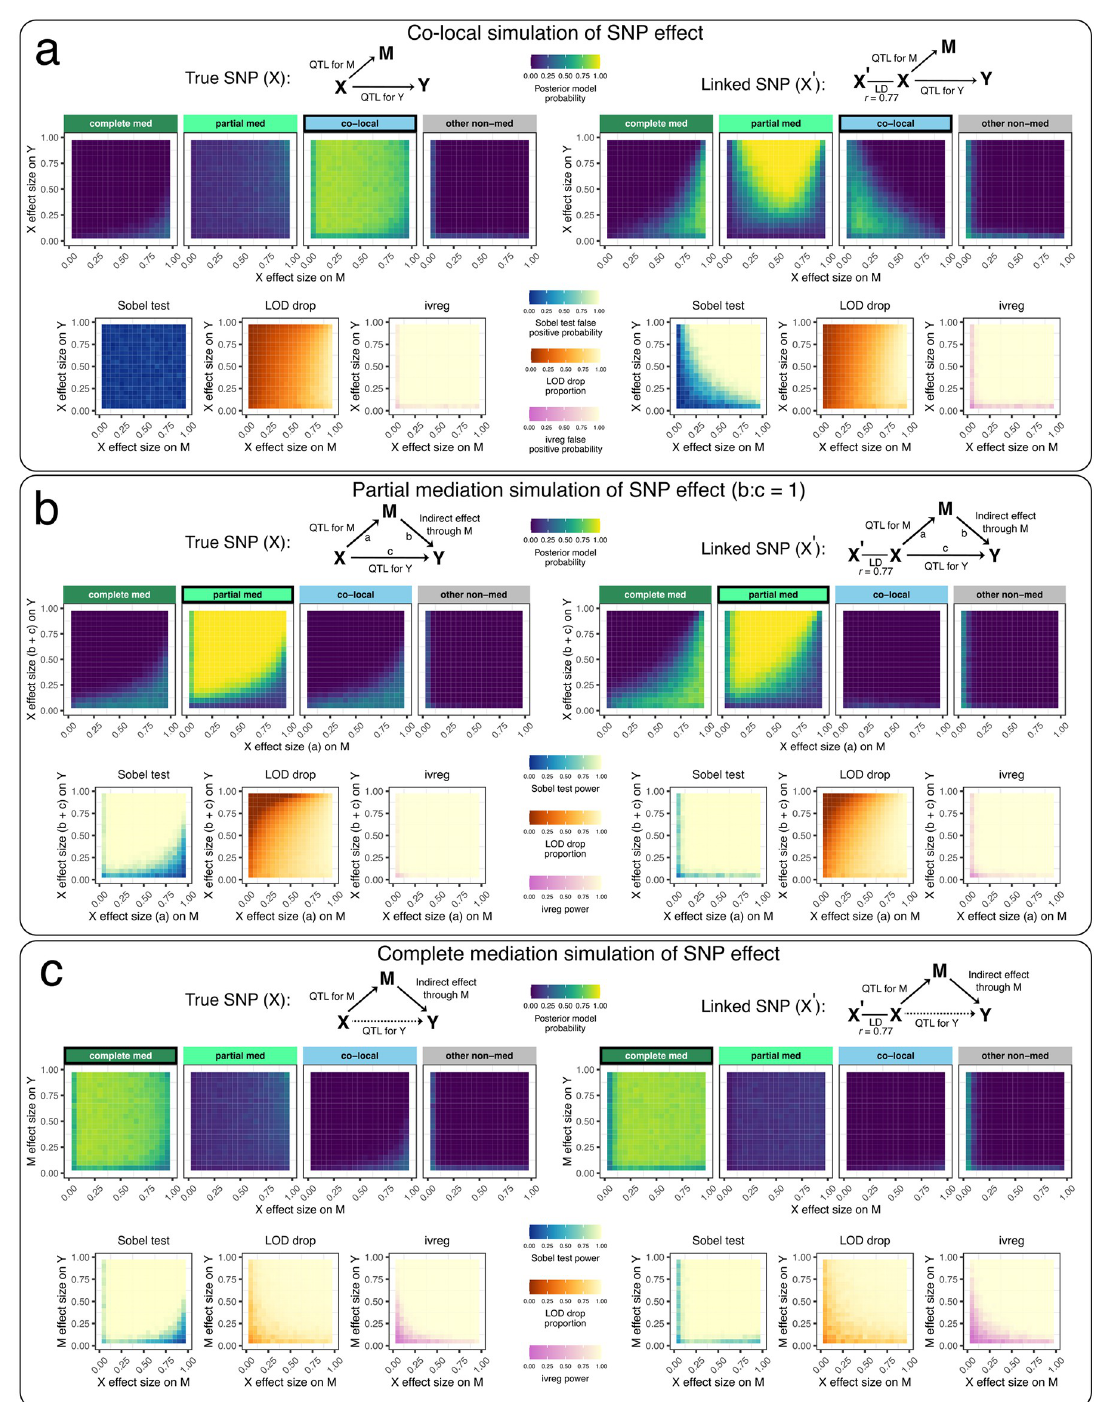
Fig 2. Performance of Bayesian model selection, Sobel test, LOD drop, and IV regression in simulated data with a binary exogenous variable. Data for 200 individuals were simulated according to (a) co-local, (b) partial mediation, and (c) complete mediation models based on a balanced bi-allelic variant X. We applied causal analysis with X as the true variant (left) and as a variant in linkage disequilibrium ( r = 0.77) with the true variant (right). DAGs indicate the model used to simulate the data. Heat maps for Bayesian model selection represent the mean posterior probability associated with each inferred model for a range of fixed settings of the model parameters as indicated on x- and y-axes, each simulated 100 times. Heat maps for the Sobel test and IV regression represent false positive probability for co-local simulations and power for mediation simulations. Heat maps for LOD drop represent mean LOD drop,